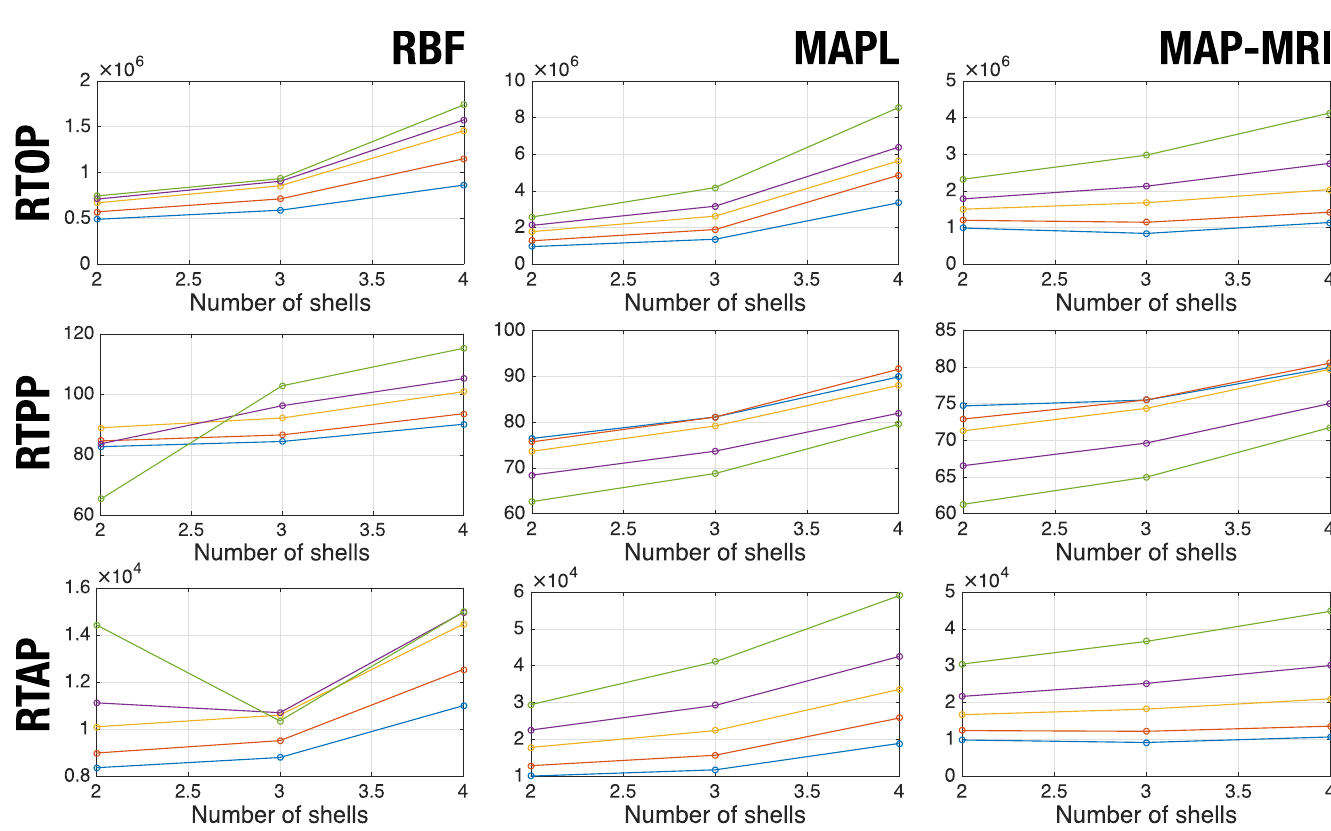
Fig 8. Measured values with multi-shell techniques as a function of the number of shells acquired. Each line correspond to a cluster from 5-fold fuzzy c-means.